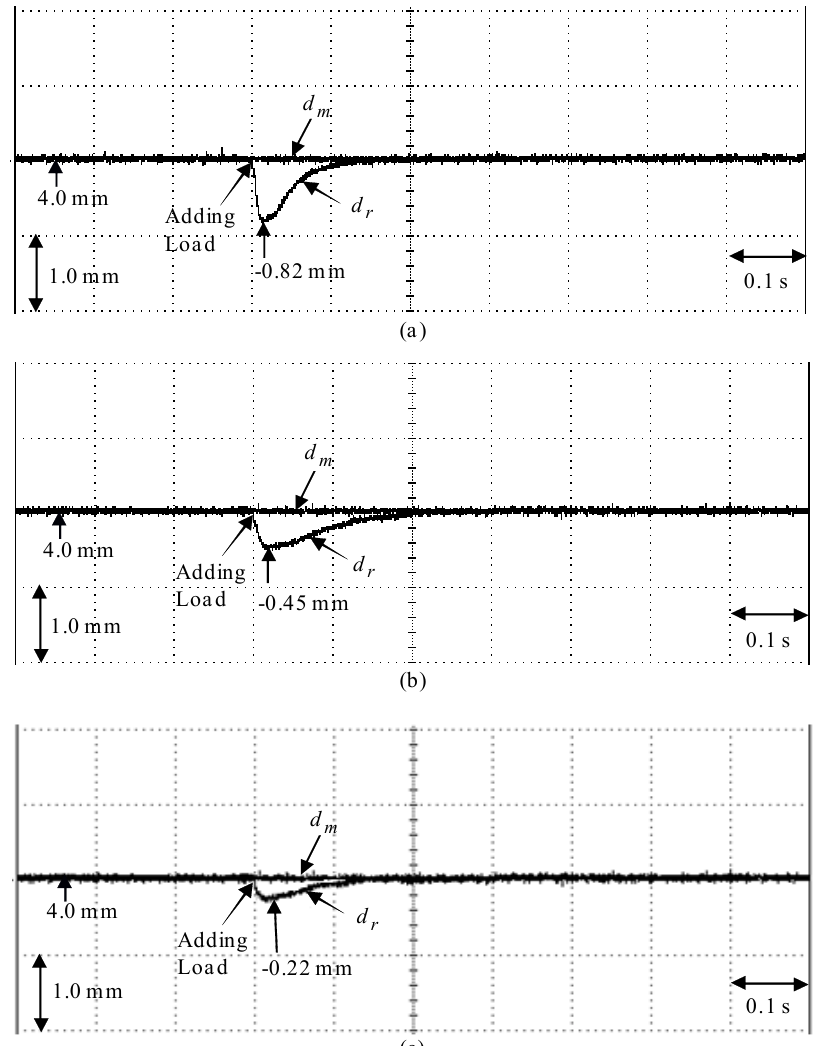
Figure 17. Experimental results of measured mover position reaction in Case 5: ( a ) by use of the renowned PI controller, ( b ) by use of the backstepping control system, ( c ) by use of the proposed AAENNB control system.